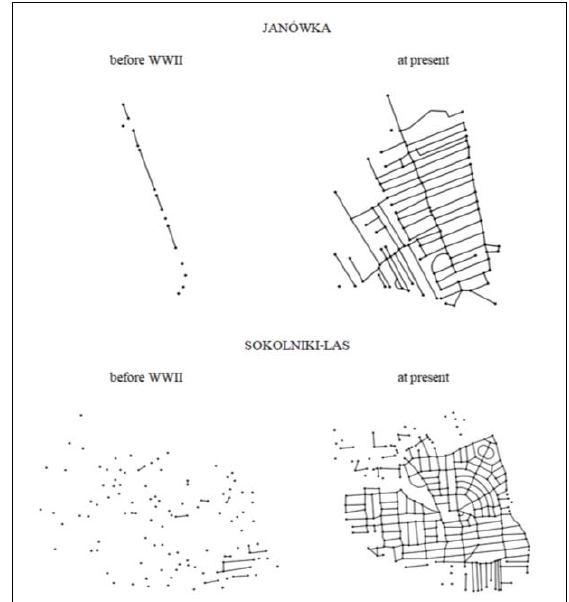
Fig. 9. Graphs depicting the high rank of morphological changes of the villages Janówka and Sokolniki-Las (in the extra-urban area) (Source: own